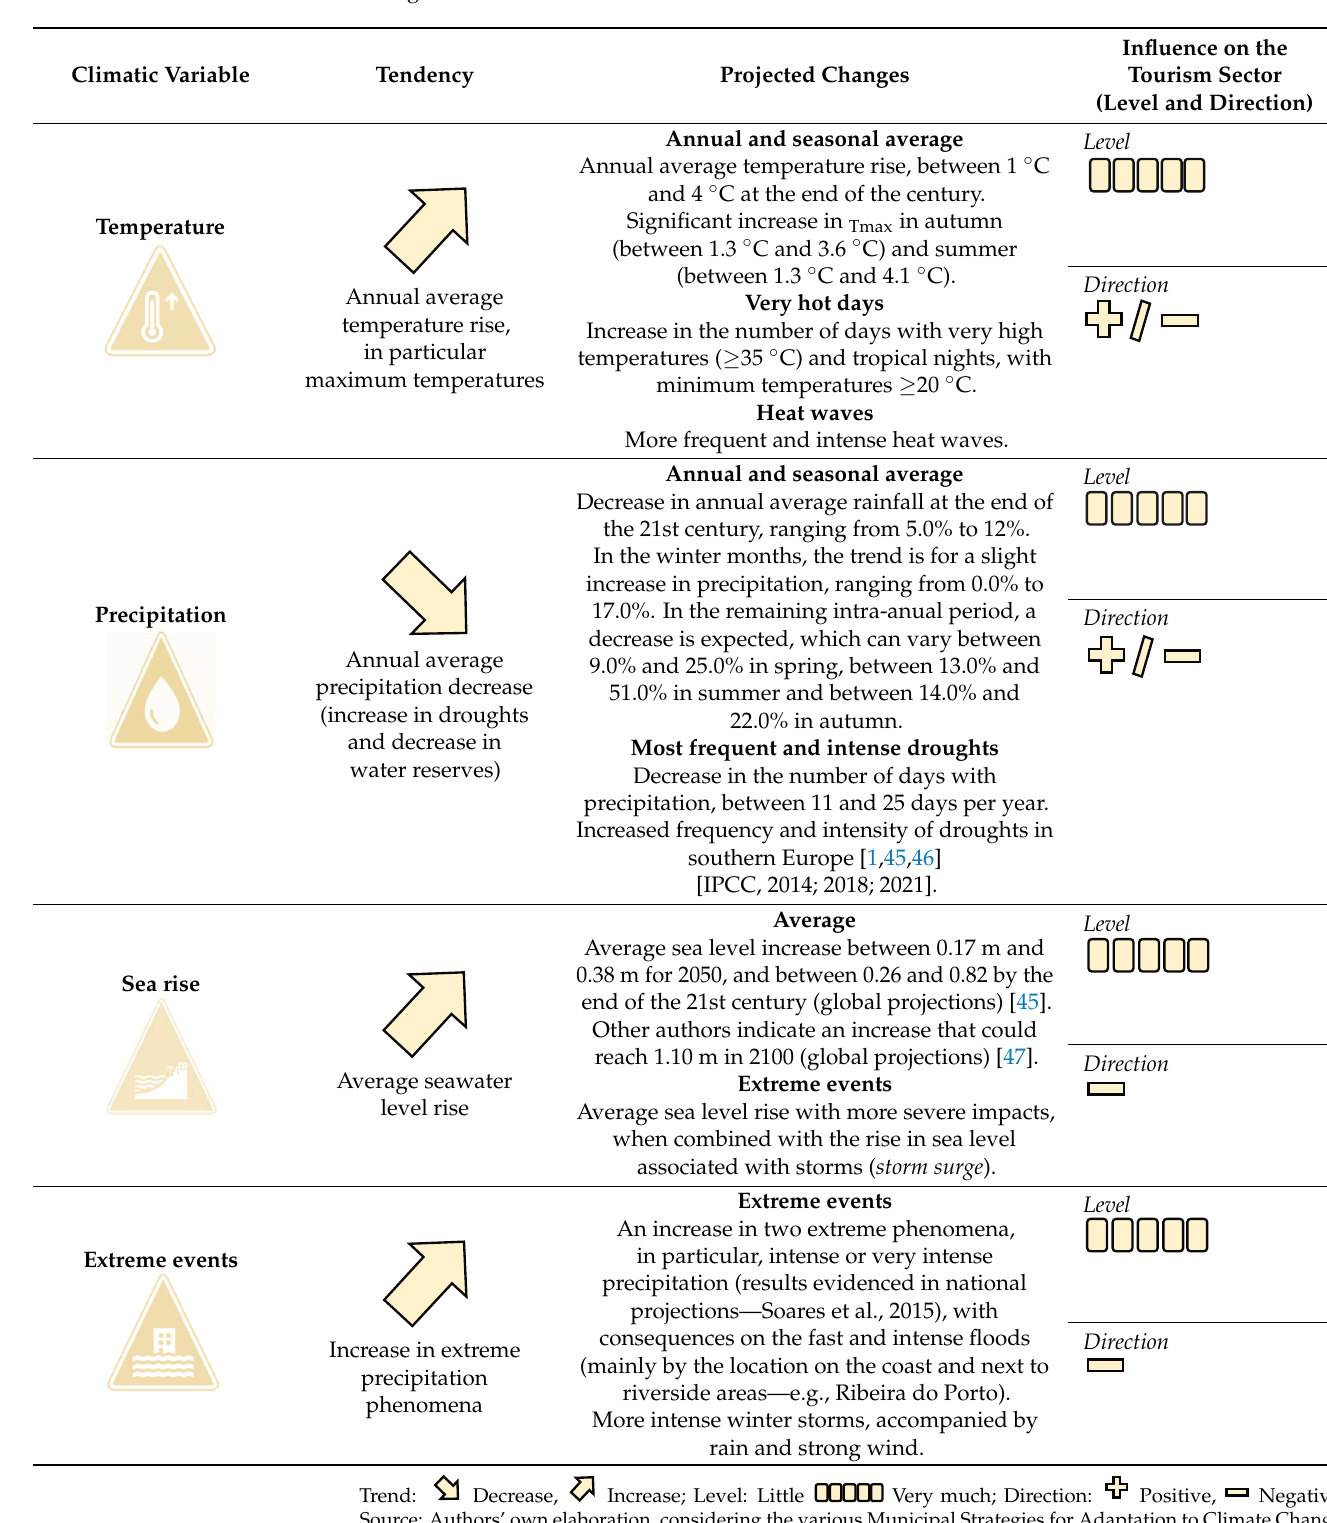
Table 1. Main consequences of climate change in the medium and long term—trends, projected changes and influence on the tourism sector.